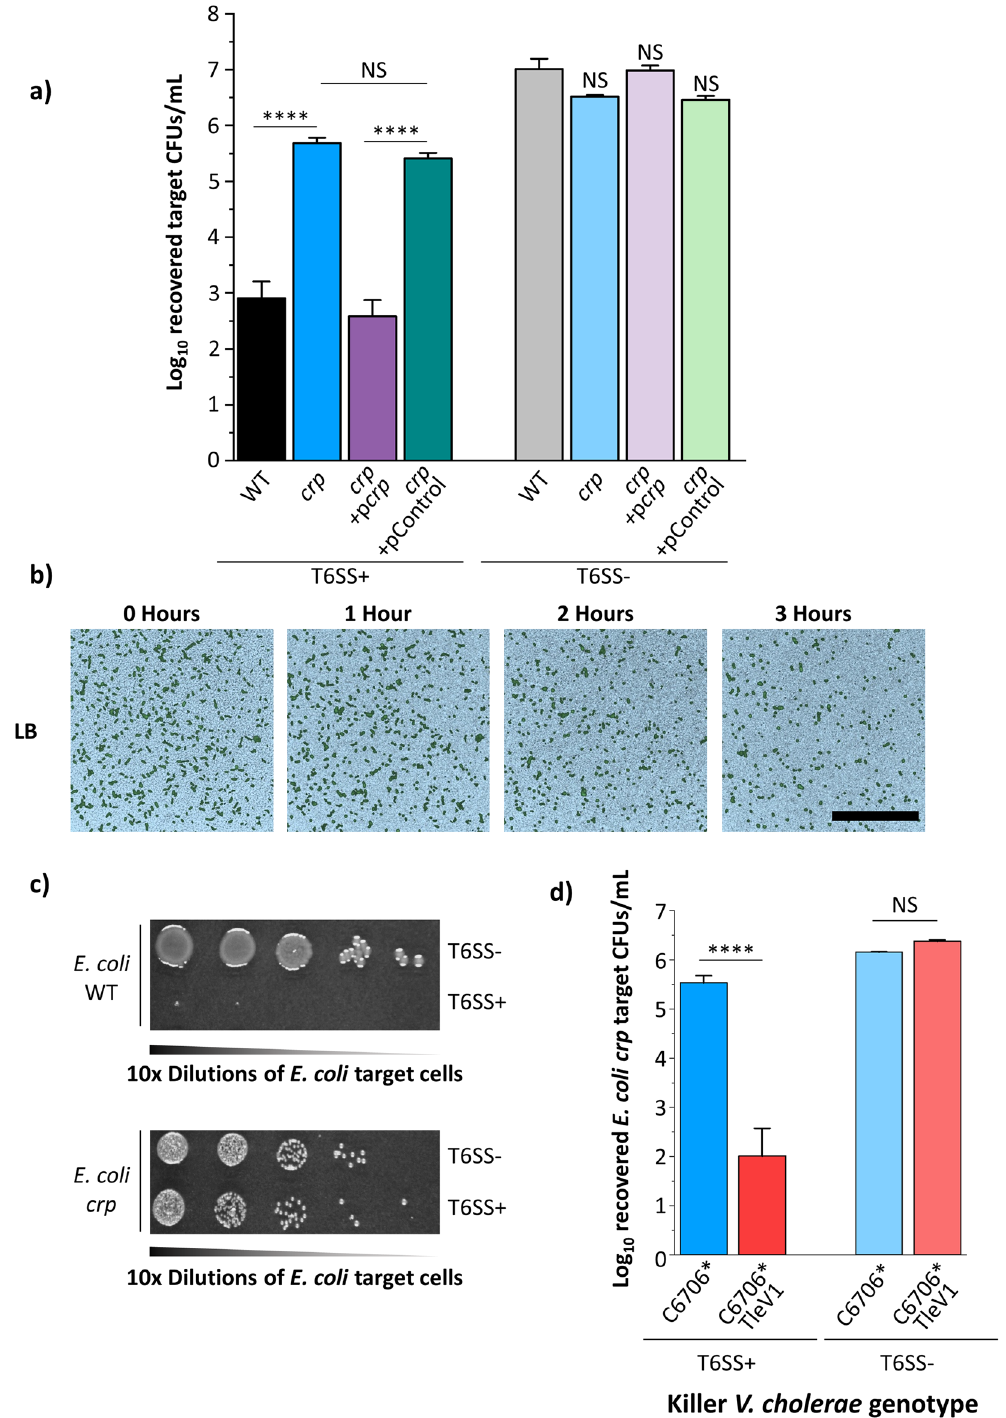
Figure 4. A crp disruption confers protection to E. coli MG1655 cells in the absence of glucose. ( a ) E. coli MG1655 cells with a crp disruption harboring the indicated plasmids were co-cultured with V. cholerae C6706* (or V. cholerae C6706* T6SS-) on LB medium. A two-way ANOVA with a post hoc Bonferroni test was used to determine significance. A minimum of 3 independent replicates were analyzed. ( b ) Fluorescently labeled green E. coli MG1655 crp cells were densely co-cultured with unlabeled killer V. cholerae C6706* on LB and the same frame was imaged for three hours using confocal microscopy. Brightfield images (bright blue pseudocolor) were overlaid with the fluorescence signal of E. coli cells projected on a plane parallel to the agar substrate. Scale bar is 50 µm. ( c ) Killer V. cholerae C6706* was co-cultured with both wild type E. coli MG1655 and E. coli crp target cells and then diluted and plated as described in the “Methods” section. ( d ) V. cholerae C6706* or V. cholerae C6706* with TleV1 (or the T6SS- mutant of each one) were co-cultured with E. coli MG1655 crp on LB medium. A two-way ANOVA with a post hoc Bonferroni test was used to determine significance. A minimum of 3 independent replicates were analyzed. ****p < 0.0001, NS not